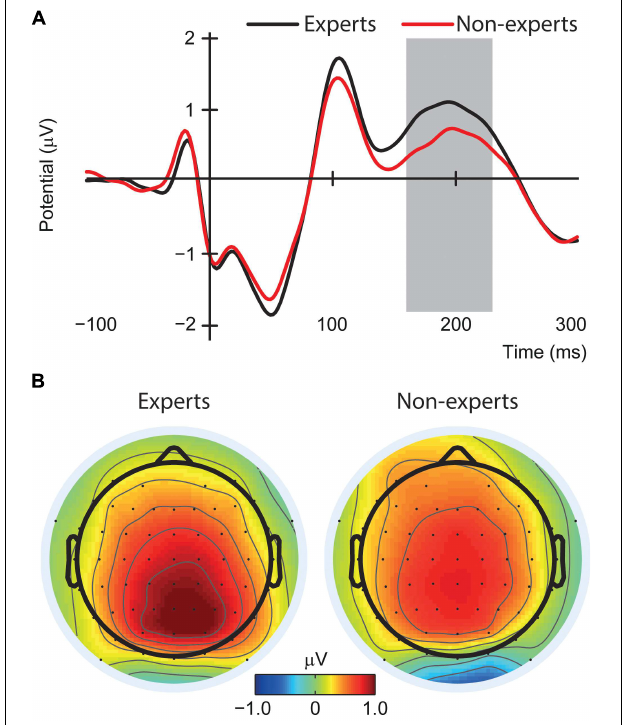
FIGURE 4 | (A) The effect of expertise on the P2 amplitude recorded from the right parietal electrode (P4) in the focal mode (collapses for eye fixations on beautiful and not beautiful paintings) – the parietal P2 time window is indicated by the gray field; (B) Topographic maps of fixation onset – related brain activity in 160–230 ms time window (focal